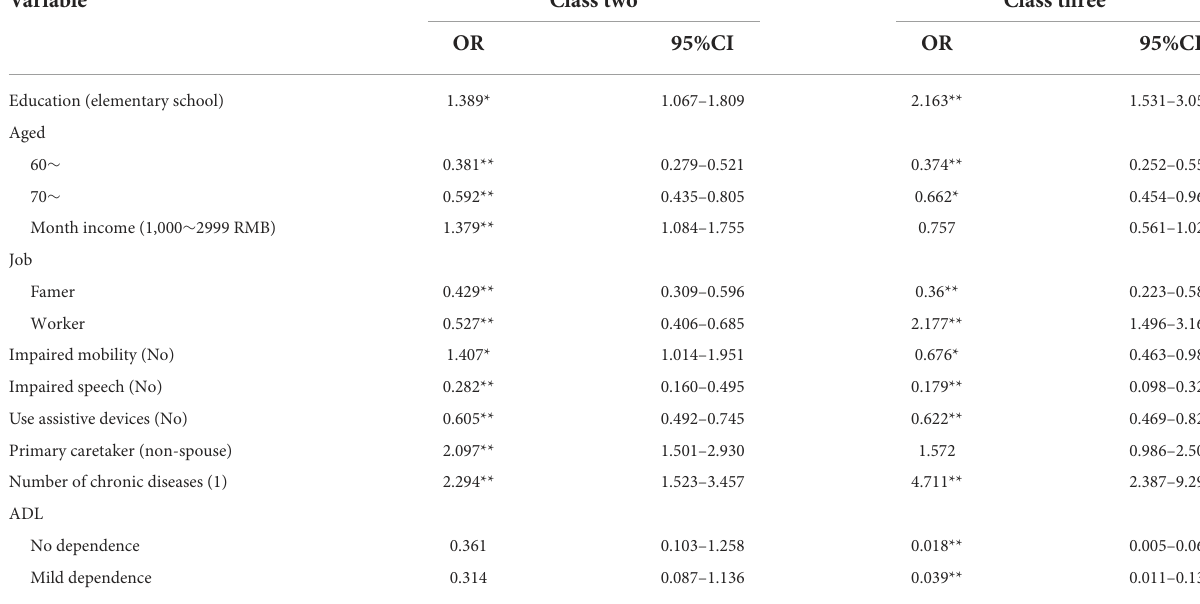
TABLE 5 Multinomial logistic regression on IPA